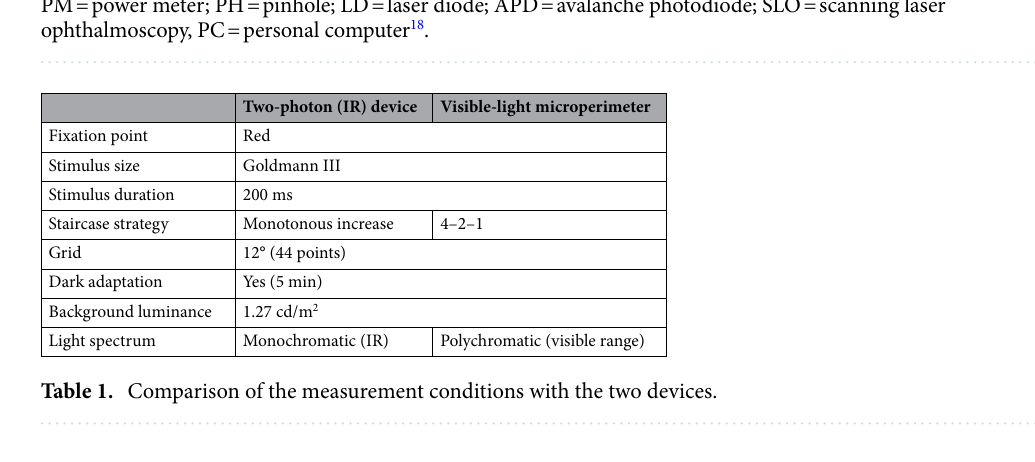
Figure 2. Block diagram of the the optical setup for infrared-light retinal-sensitivity measurements. λ = wavelenght; F = repetition frequency; τ = pulse width; SM = single mode; NDF = neutral density filter;